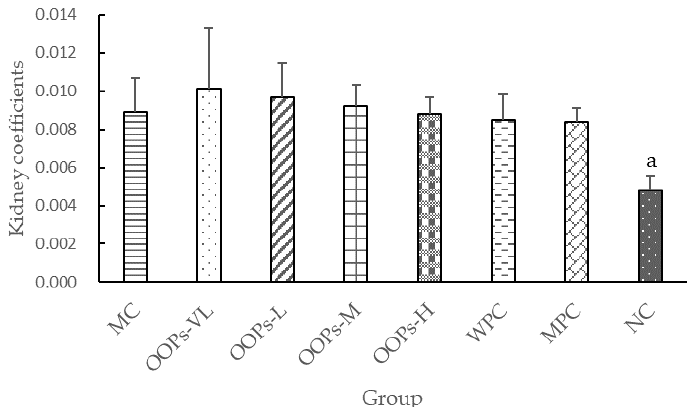
Figure 5. Effect of OOPs treatment on the kidney coefficient. Values are expressed as the means ± SD of 8 rats in each group. a p < 0.05 versus MC group.